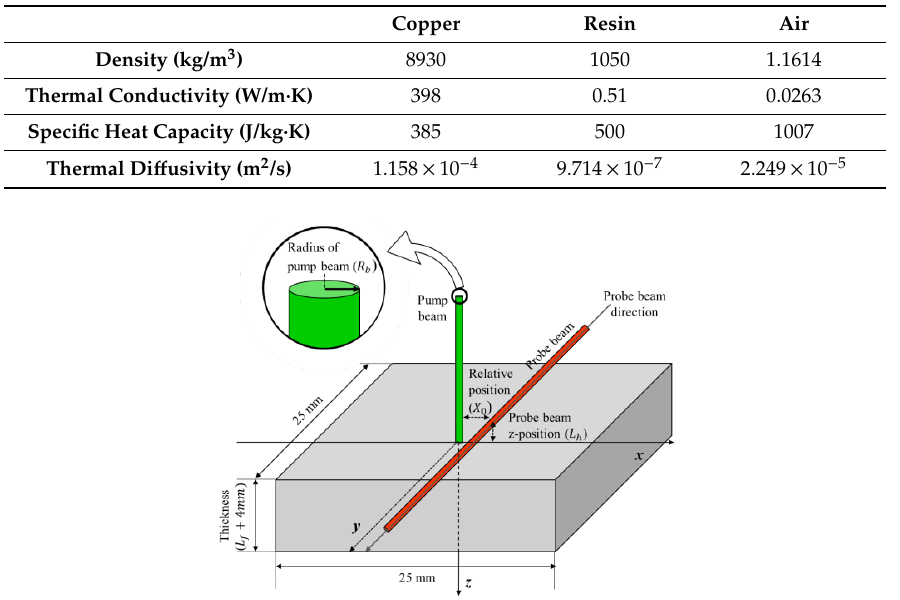
Figure 5. Optical arrangement of the specimens and laser.